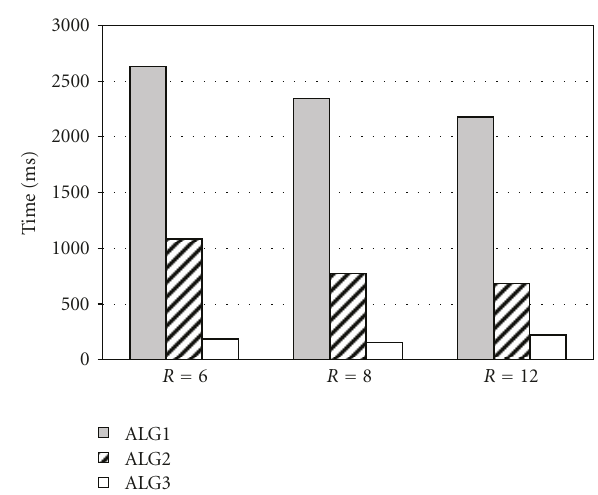
Figure 11: Average time to find five proxies with low connectivity ( P actual = 30%; data rate = 250Kb/s).